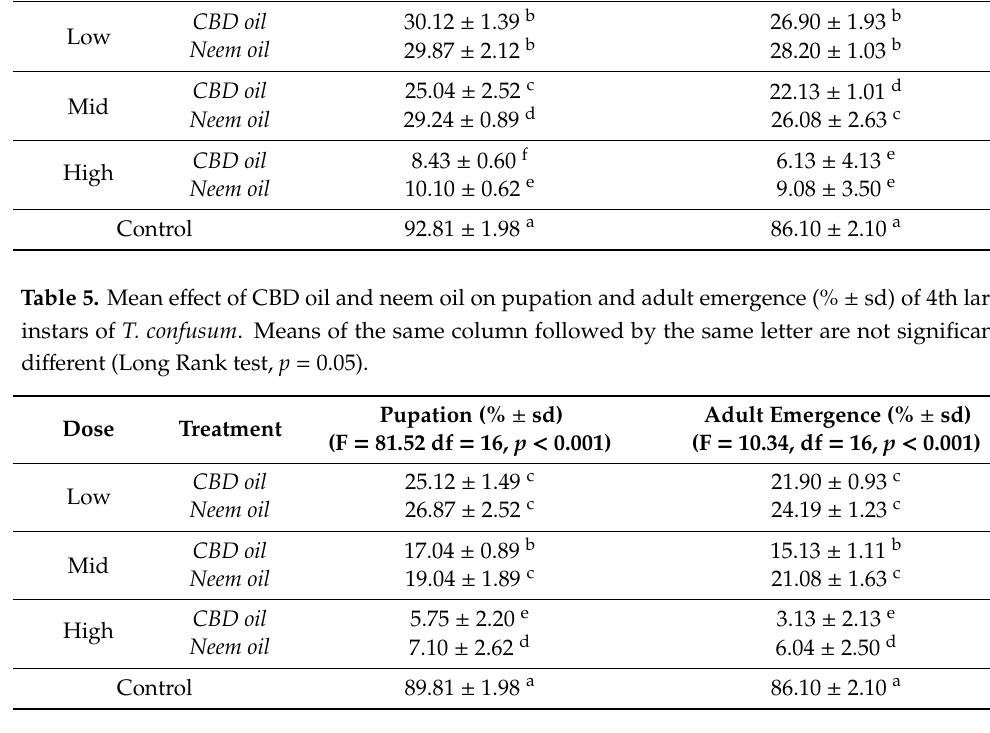
Table 6. Mean e ff ect of CBD oil and neem oil on pupation and adult emergence (% ± sd) of 4th larval instars of O. surinamensis. Means of the same column followed by the same letter are not significantly di ff erent (Long Rank test, p =